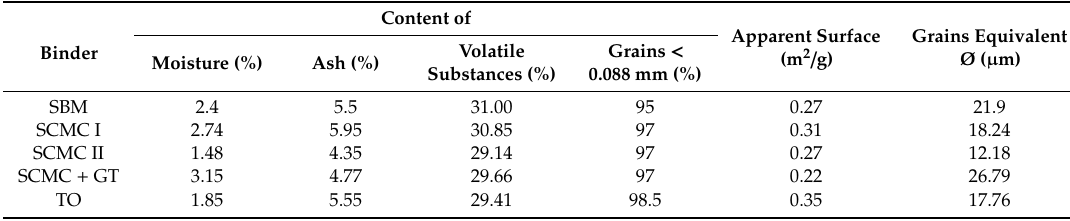
Table 5. Properties of coal